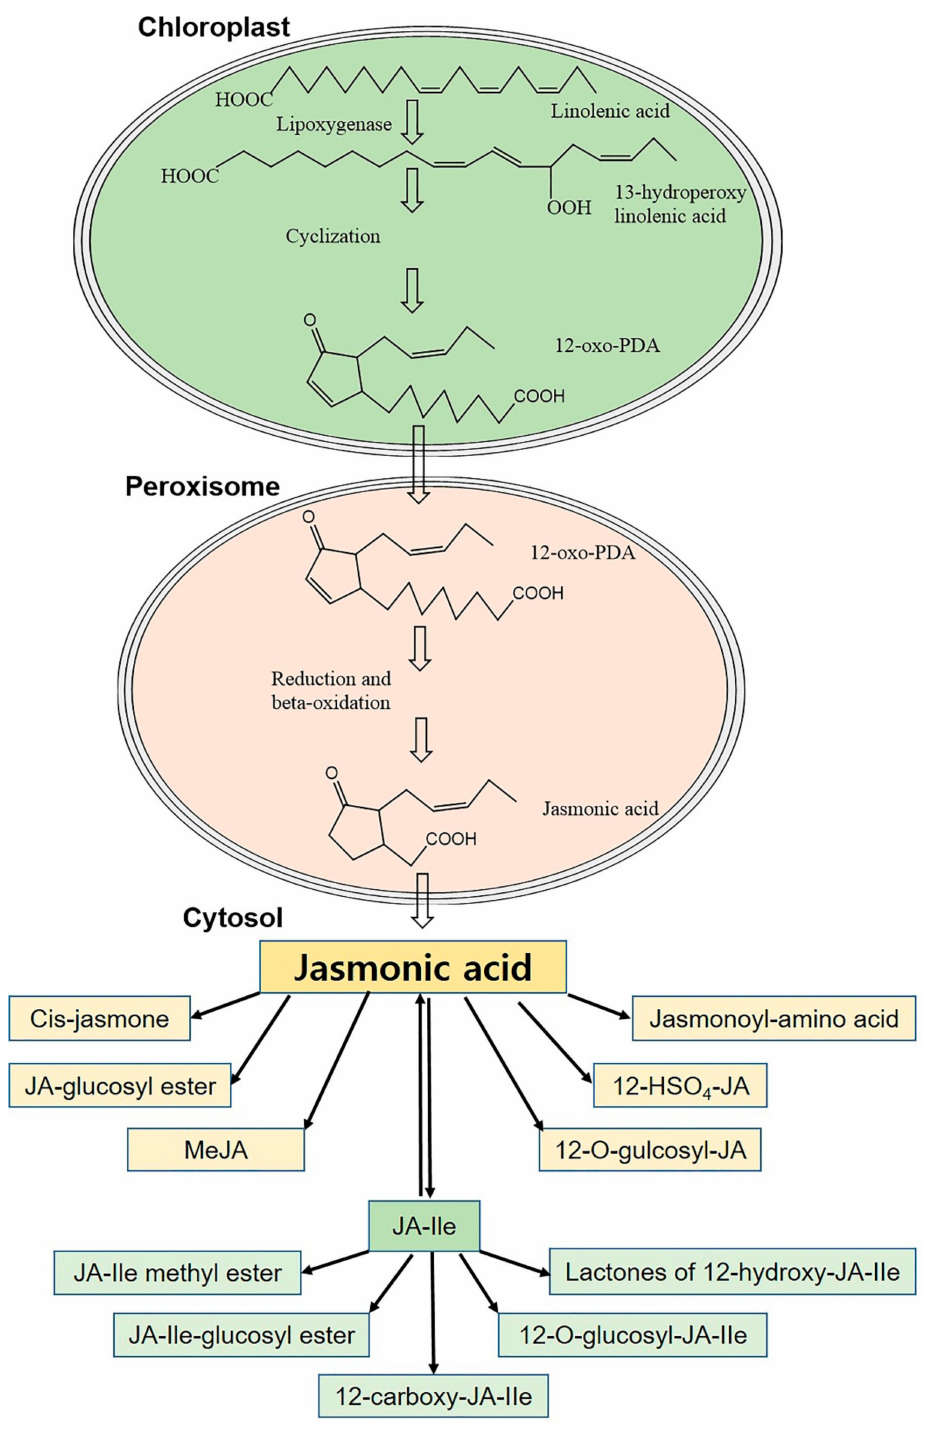
Figure 2. Schematic diagram of jasmonic acid biosynthesis and metabolism in response to abiotic stresses. In the chloroplast, JA biosynthesis begins with the chloroplast membrane release of linolenic acid, which is finally converted to 12-oxo-PDA. Upon transport of 12-oxo-PDA into the peroxisome, a series of enzymes work to convert it to JA, which is then exported to the cytoplasm. JA may be metabolized into di ff erent compounds depending on the chemical modification of the carboxylic acid group, the pentenyl side chain, or the pentanone ring. JA, jasmonic acid; JA-Ile, jasmonyl isoleucine; MeJA, methyl jasmonate; 12-HSO 4 -JA, 12-hydroxyjasmonic acid sulfate; 12-oxo-PDA, 12-oxo-phytodienoic